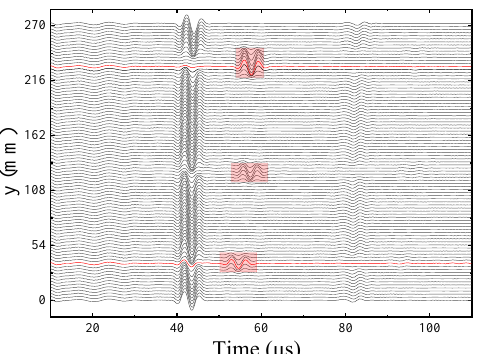
Figure 11. Measurement waveforms at the same height of grooved sandstone Plate 1.